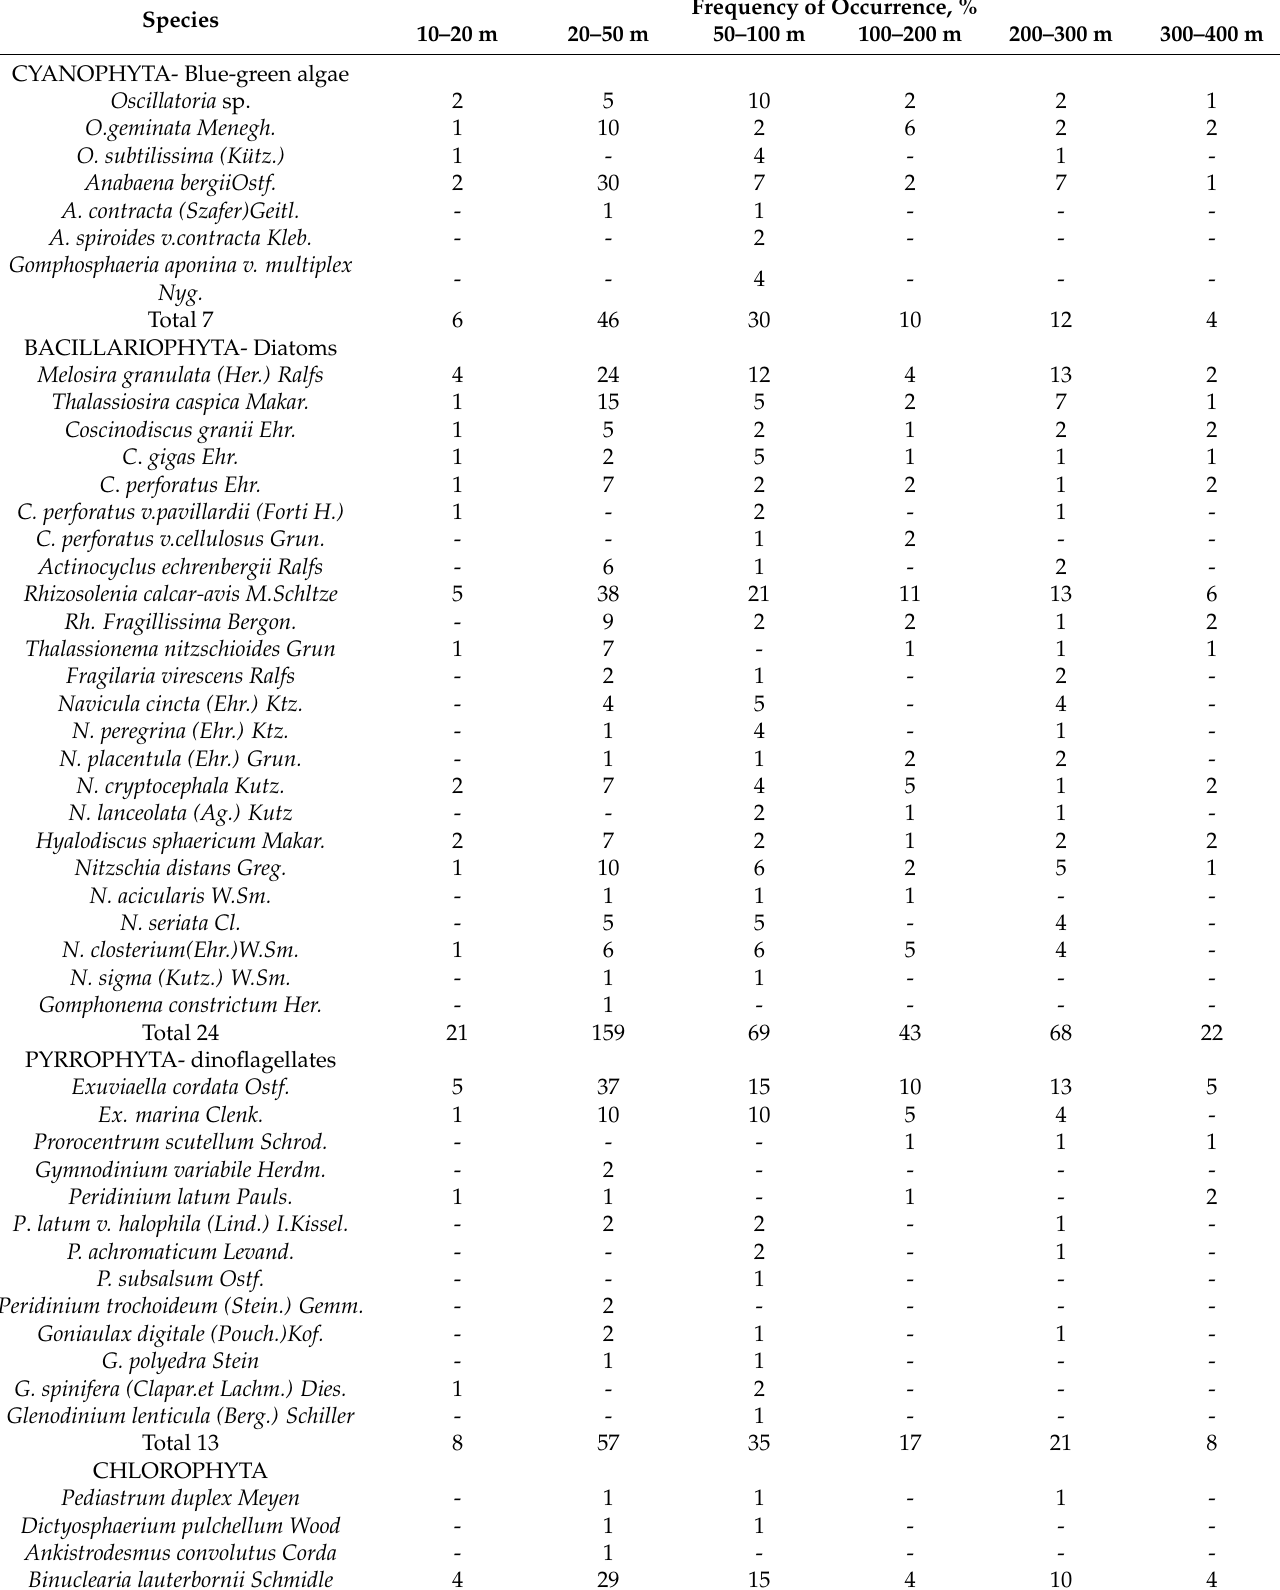
Table 1. Species composition and frequency of occurrence of phytoplankton in the eastern part of the Middle